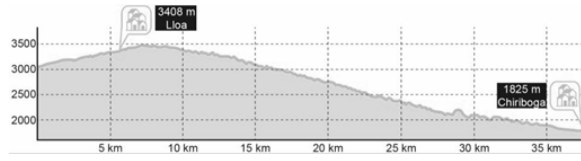
Figure 7: Reliefs maps